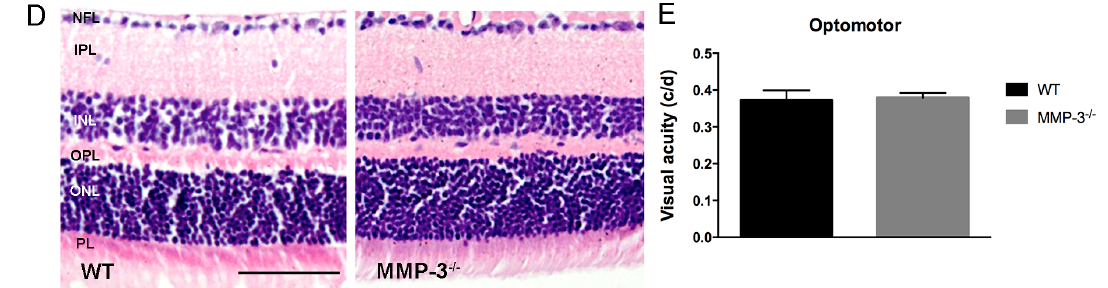
Figure 2. Retinal morphology and visual acuity of healthy WT and MMP-3 − / − mice. ( A ) Absence of pro- and mature MMP-3 in the retina and RPE of MMP-3 − / − mice was confirmed via Western blotting. Lava purple staining served as a loading control; ( B ) Representative spectral domain optical coherence tomography (SD-OCT) pictures showed no difference in general morphology of the retina in WT and MMP-3 − / − mice. Scale bar: 100 µm; ( C ) Analysis of SD-OCT images revealed a similar thickness of the ganglion cell complex (GCC), which includes the nerve fiber layer (NFL), ganglion cell layer (GCL) and inner plexiform layer (IPL), and of the total retina in both genotypes; ( D ) Representative images of hematoxylin and eosin (H&E) stained retinal sections demonstrated no difference in the thickness of the retinal layers in WT and MMP-3 − / − eyes. Scale bar: 50 µm; ( E ) Visual acuity, assessed in a virtual optomotor device, was found to be similar in WT and MMP-3 − / − mice. Data are shown as mean ± SEM, n ≥ 8. NFL, nerve fiber layer; IPL, inner plexiform layer; INL, inner nuclear layer; OPL, outer plexiform layer; ONL, outer nuclear layer; PL, photoreceptor layer; RPE, retinal pigment epithelium.